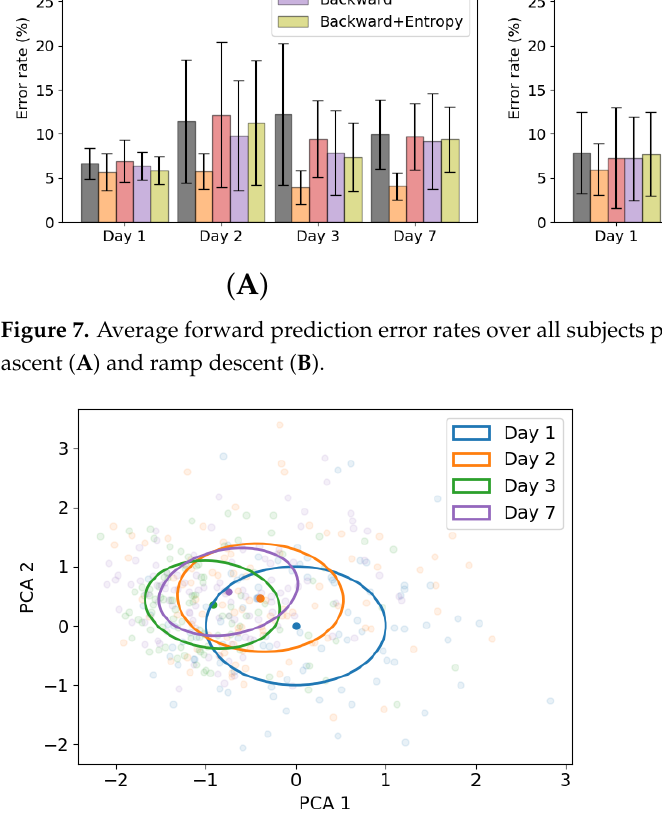
Figure 8. Projection of the extracted features on the first two principal components of day 1 during ramp walking of day 1 (blue), day 2 (orange), day 3 (green) and day 7 (purple) of one subject. Ellipses indicate one standard deviation from the mean, mean values are indicated with the darker